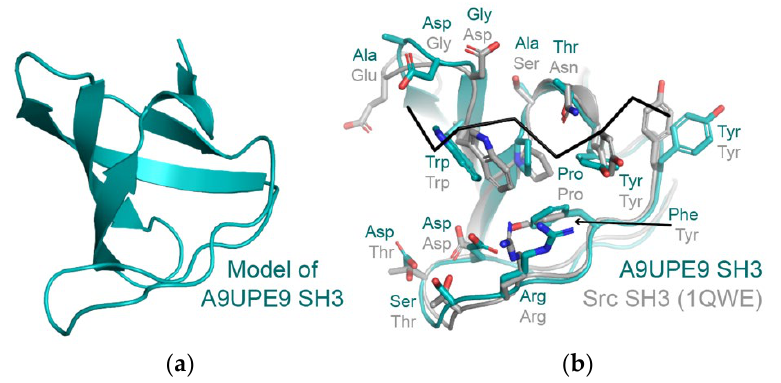
Figure 8. ( a ) A homology model of A9UPE9 SH3 is shown in cartoon representation. The template PDB ID used was 7CSO (Ephexin4 SH3). ( b ) The A9UPE9 and Src SH3 domains are in cartoon representation, with peptide-binding cleft residues in sticks, colored by heteroatom (N = blue, O = red) and labeled. The APP12 peptide is in black ribbon. Alignment of main chain atoms revealed an overall RMSD = 0.824 Å for 170 atoms.